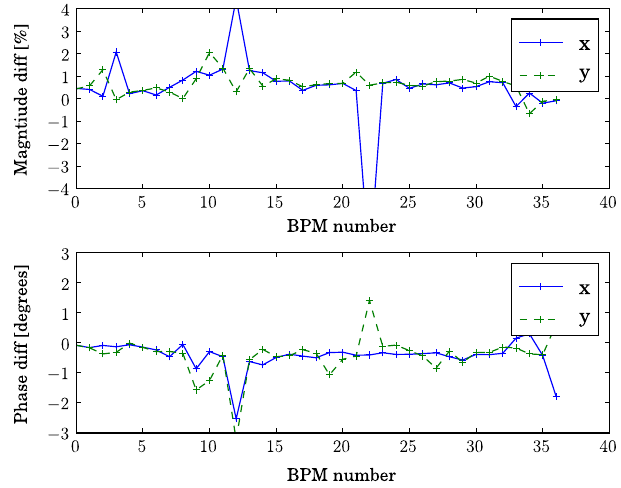
FIG. 22. Two measurements of the processing electronics rela- tive amplitude and phase separated by 4 days.